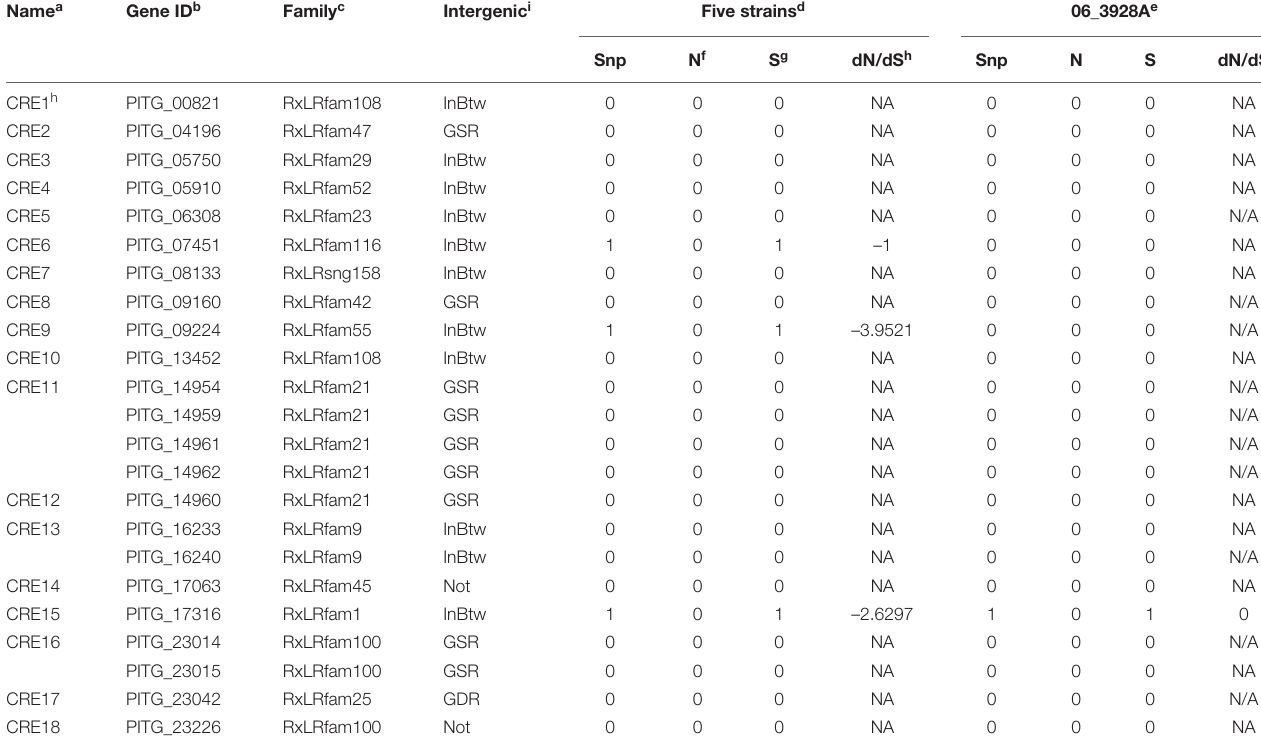
TABLE 2 | Identification of 18 conserved candidate core RXLR effector